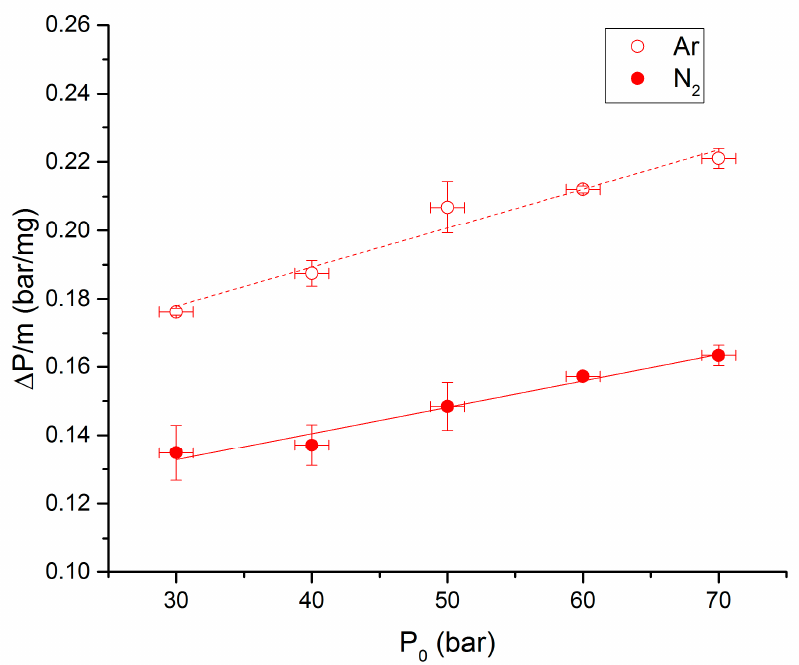
Figure 10. Overpressure vs. P0 for the 90-10 propellant under N 2 and Ar.